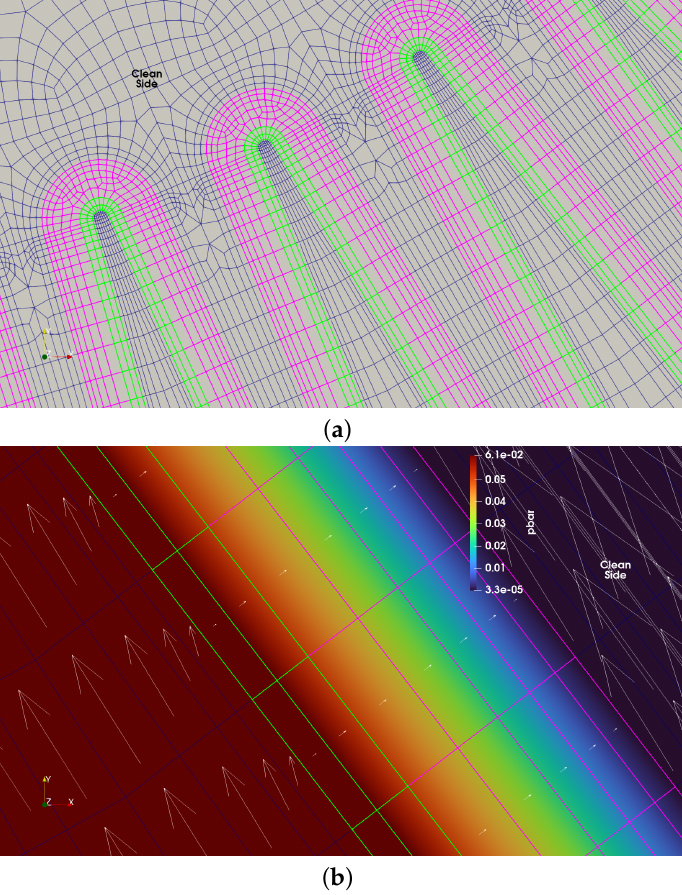
Figure 2. ( a ) Mesh detail in a plane through the filtering device (normal to z-direction); ( b ) velocity vectors and pressure drop detail through the same